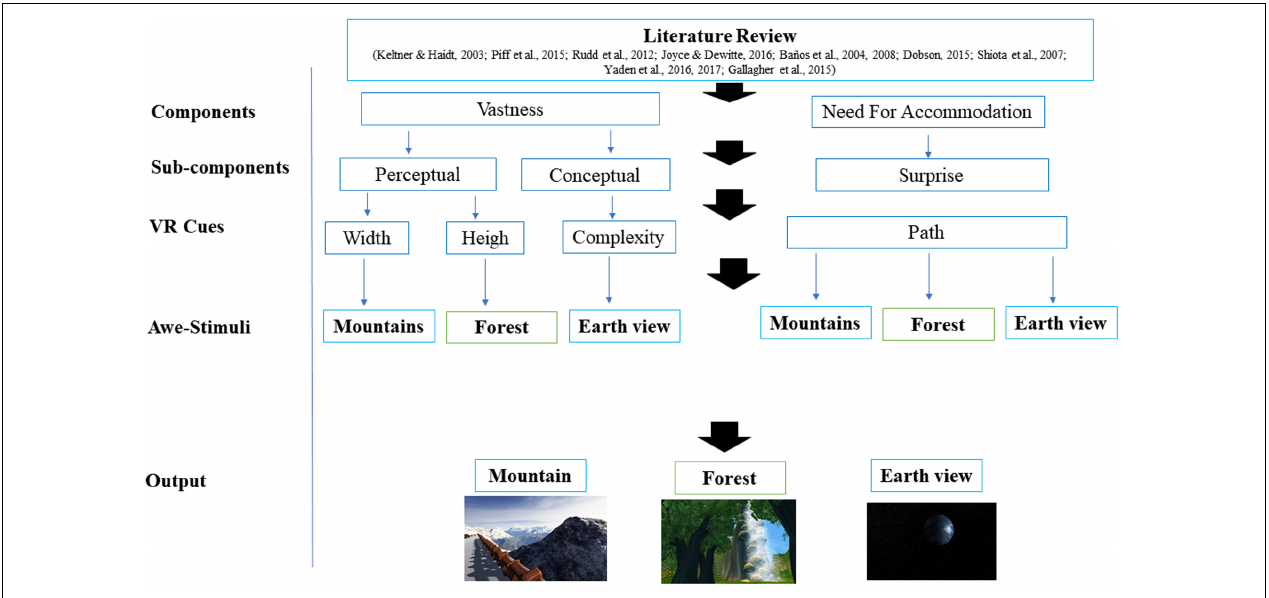
FIGURE 5 | Diagram of evidence-based stimuli